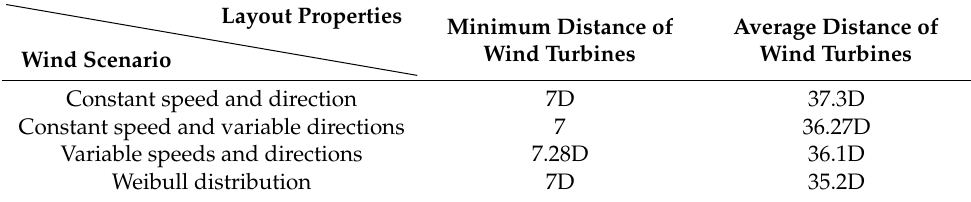
Table 4. Comparison of optimized wind farm layouts in terms of minimum and average distances between wind turbines (in the unit of turbine diameter, D) for different wind scenarios studied.